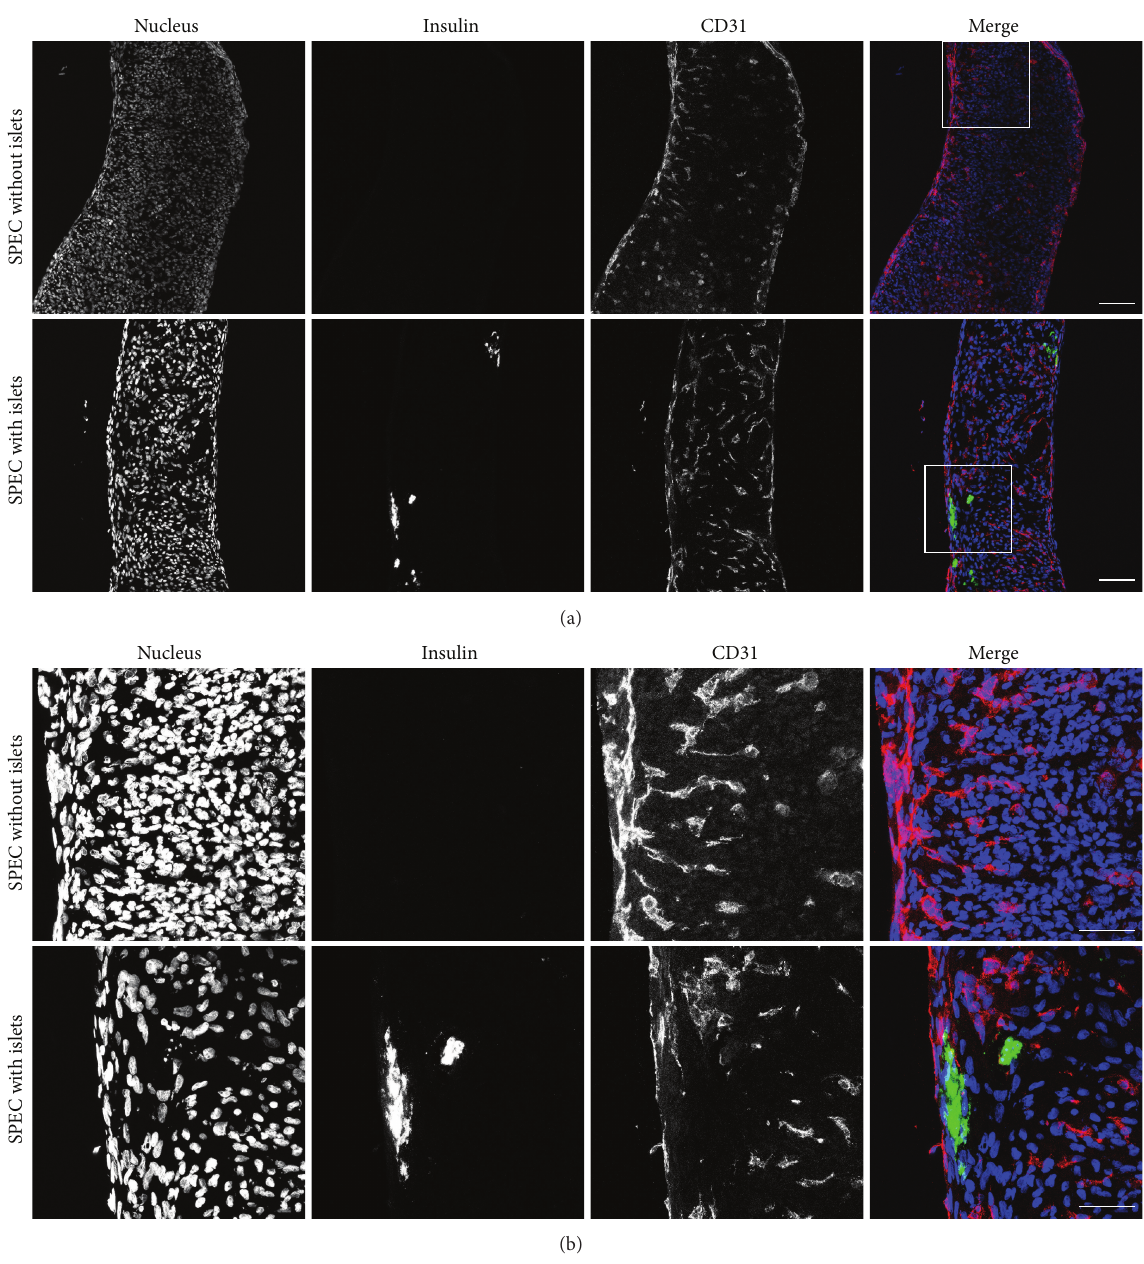
Figure2:IsletsseededintoSPECsembedthroughoutthebodyoftheconstruct.CryoembeddedSPECswithandwithoutisletsweresectioned, fixed, and labeled for nuclei (blue), islets (insulin, green), and endothelial cells (CD31, red). The images are maximum projections of z-stacks acquired by confocal microscopy under 20x magnification (a), and 63x magnification [(b), boxed region in (a)]. Islets can be seen both in the periphery and the interior of the islet-containing SPECs. It is interesting to note that the vascular network extends to the interior of the construct and that this is also not disrupted by the presence of islets. Scale bars represent 100 𝜇 m and 50 𝜇 m in (a) and (b),